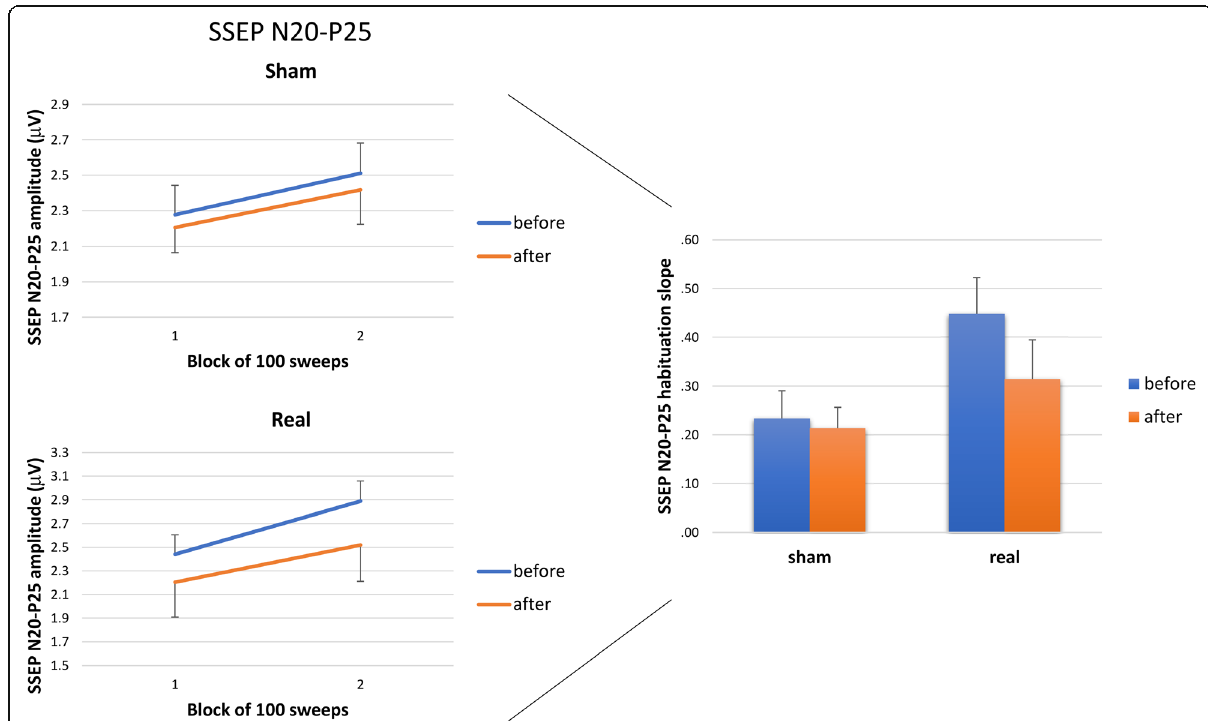
Fig. 3 Left panel: Amplitudes (mean ± standard error of the mean) of the N20 – P25 somatosensory evoked potential (SSEP) component in 2 sequential blocks of 100 recordings are shown before and after sham tDCS (upper panel) and real tDCS (lower panel). Right panel: The bar graph represents the habituation slope of SSEP N20 – P25 peak-to-peak amplitudes (mean ± standard error of the mean) before and after sham tDCS and real